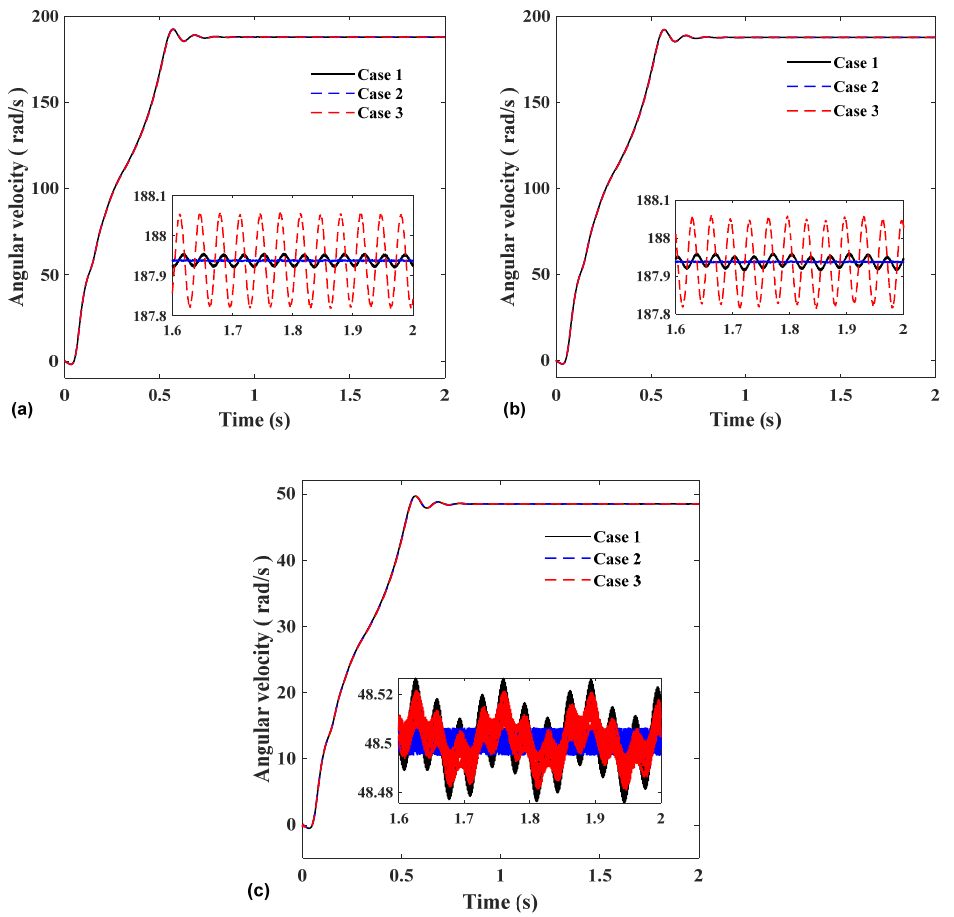
Figure 12. Comparison of experimental group, control group 1, and control group 2: ( a ) Gear 1; ( b ) Gear 2; and ( c ) Gear 3.